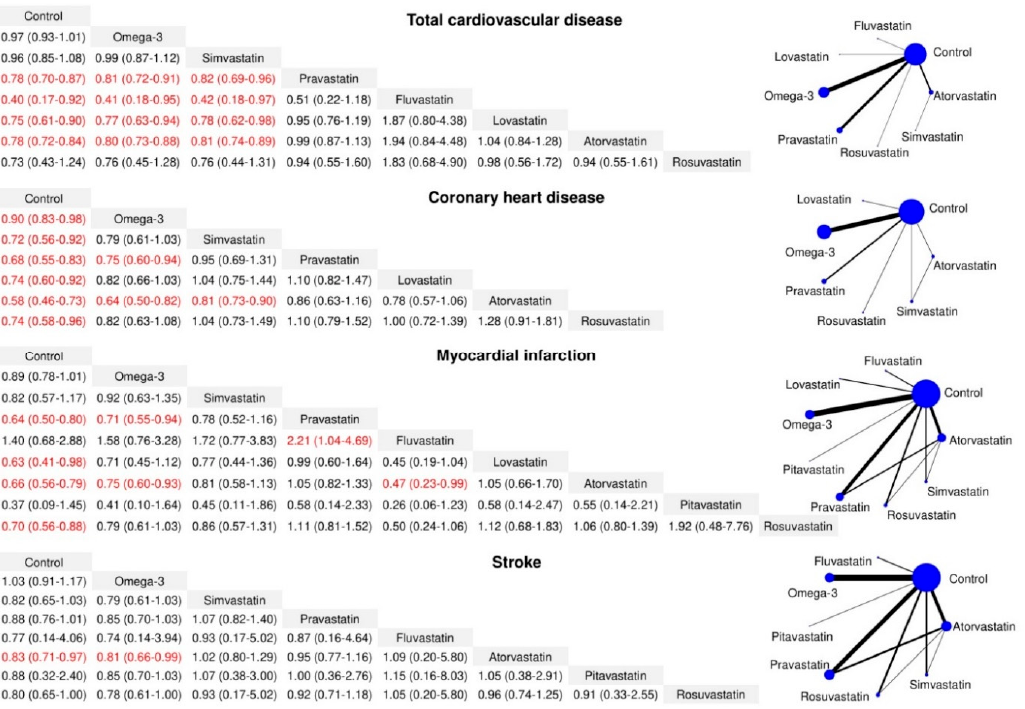
Figure 2. Network meta-analysis of statin, omega-3, and control in the risk of different cardiovascular